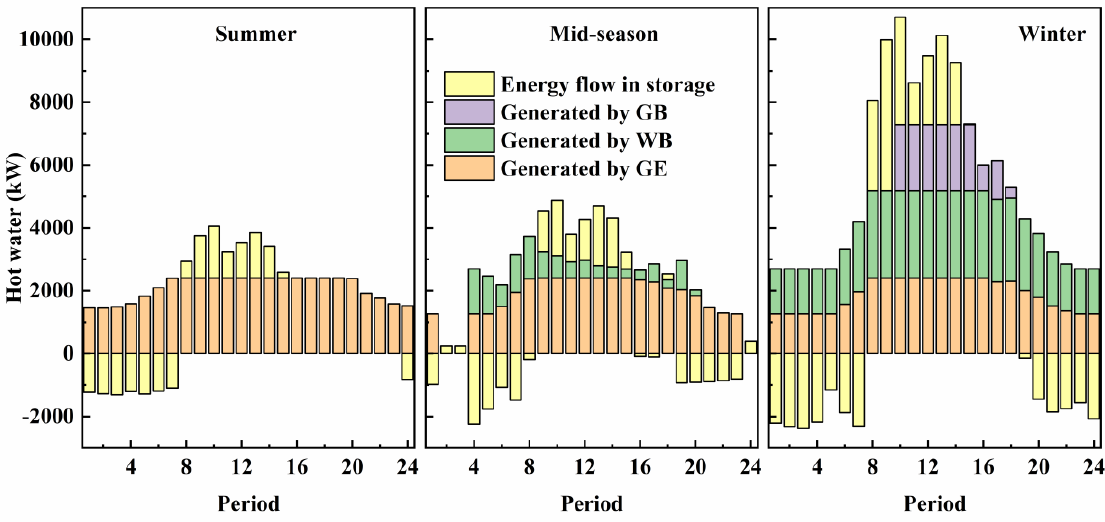
Figure 9. Heating balance in Case 4 during the three typical days.